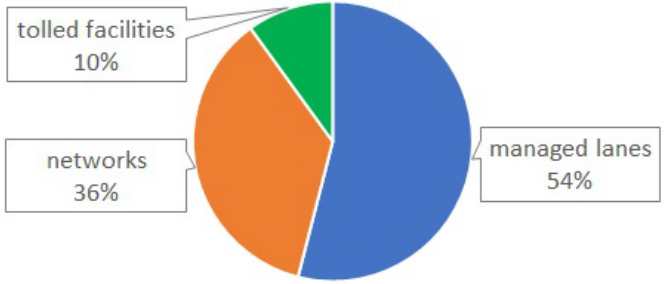
Figure 1. Distribution of the analyzed dynamic toll pricing studies by scope.